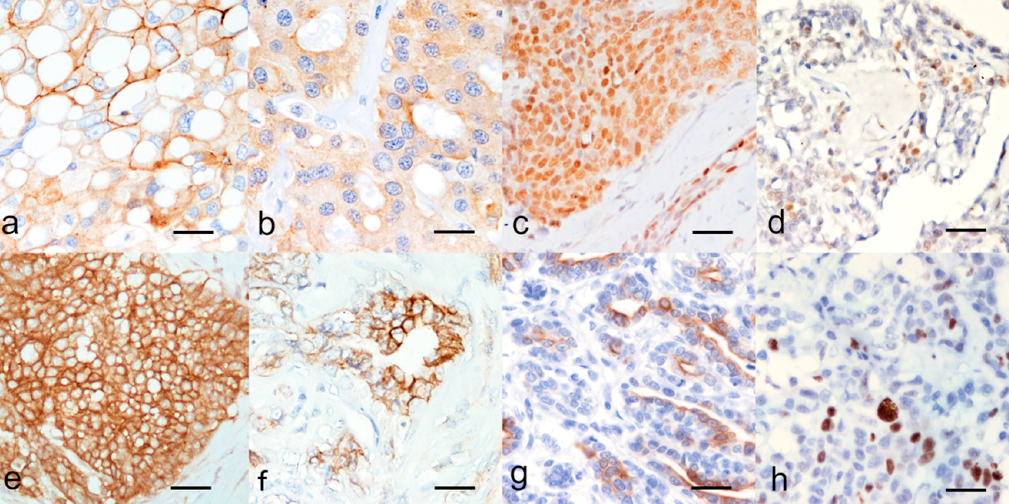
Figure 2. Immunohistochemical markers of CMCs. Positivity to ( a ) P-glycoprotein (P-gp strong membranous and weak/moderate multifocal cytoplasmic), ( b ) Breast Cancer Resistance Protein (BCRP membranous and multifocal cytoplasmic), ( c ) Estrogen Receptor alpha (ER α , nuclear), ( d ) Progesterone Receptor (PR, nuclear), ( e ) score 3 + for Human Epidermal Growth Factor Receptor type 2 (HER2, strong complete membranous labeling in all the neoplastic cells), ( f ) Epidermal Growth Factor Receptor type 1 (EGFR, membranous), ( g ) basal cytokeratin 5 and 6 (CK5/6, cytoplasmic), and ( h ) nuclear positivity to Ki67. Indirect immunohistochemistry, ( a , b ) magnification × 400, ( c – h ) magnification × 200.